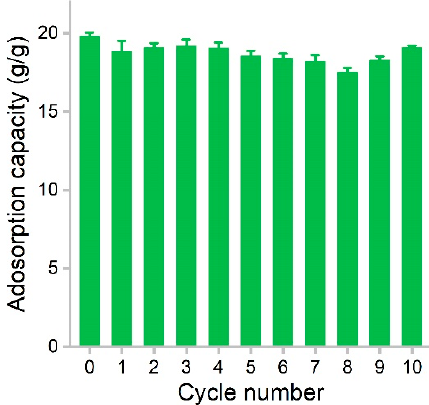
Figure 7. Regeneration of PCS during the removal of dodecane.